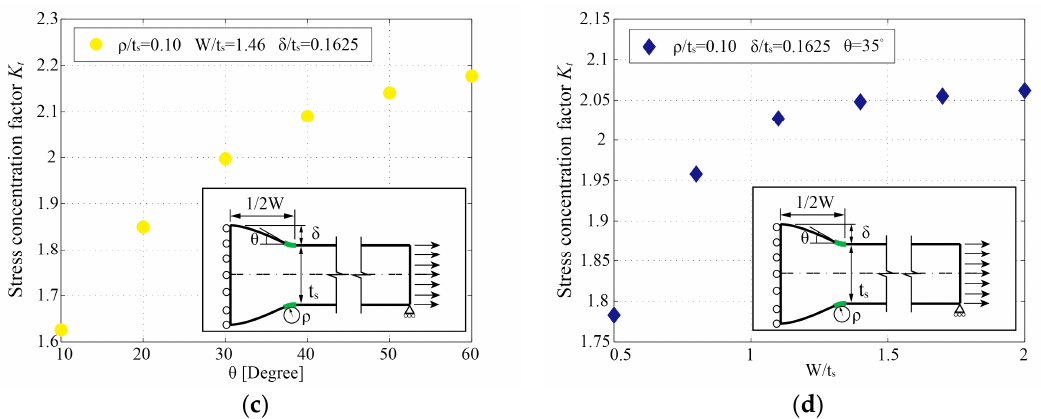
Figure 6. The influences of parameters on the stress concentration factor (SCF) ( K t ): ( a ) reinforcement height; ( b ) weld toe radius; ( c ) flank angle; ( d ) weld width.